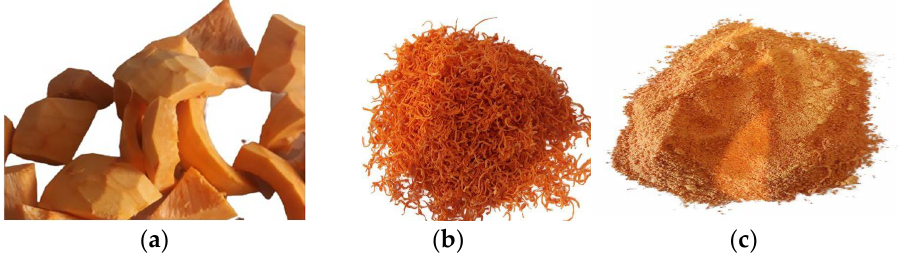
Figure 1. The process of the preparation of the PF (( a )—cutting process, ( b )—after the dryer, ( c )— pumpkin